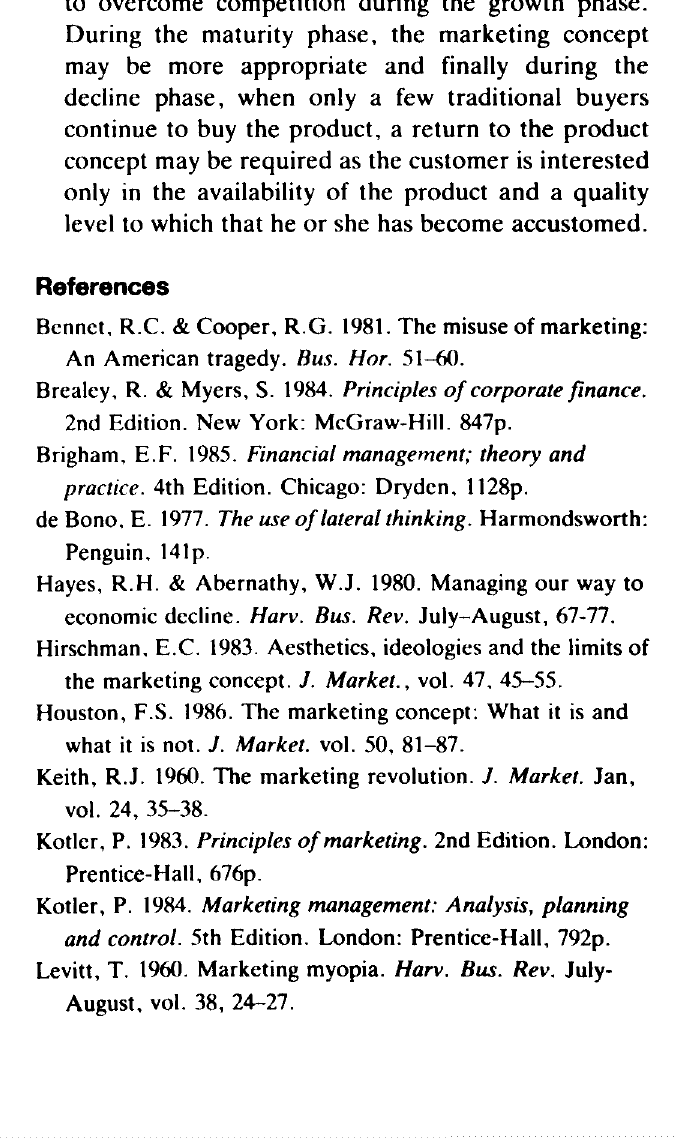
Figure 3 Concept mix of an hypothetical drug